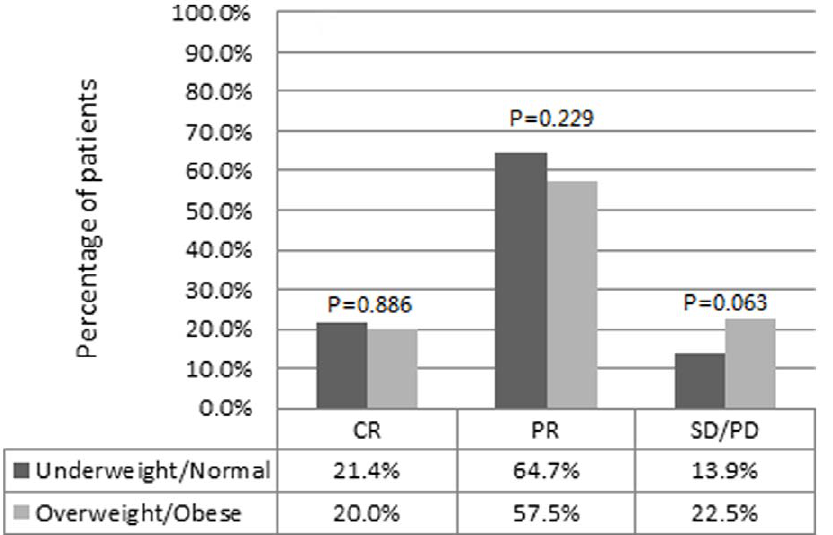
Figure 1. Clinical response to neoadjuvant chemotherapy and BMI category. CR, complete remission; PR, partial remission; SD, stable disease; PD, progression disease.